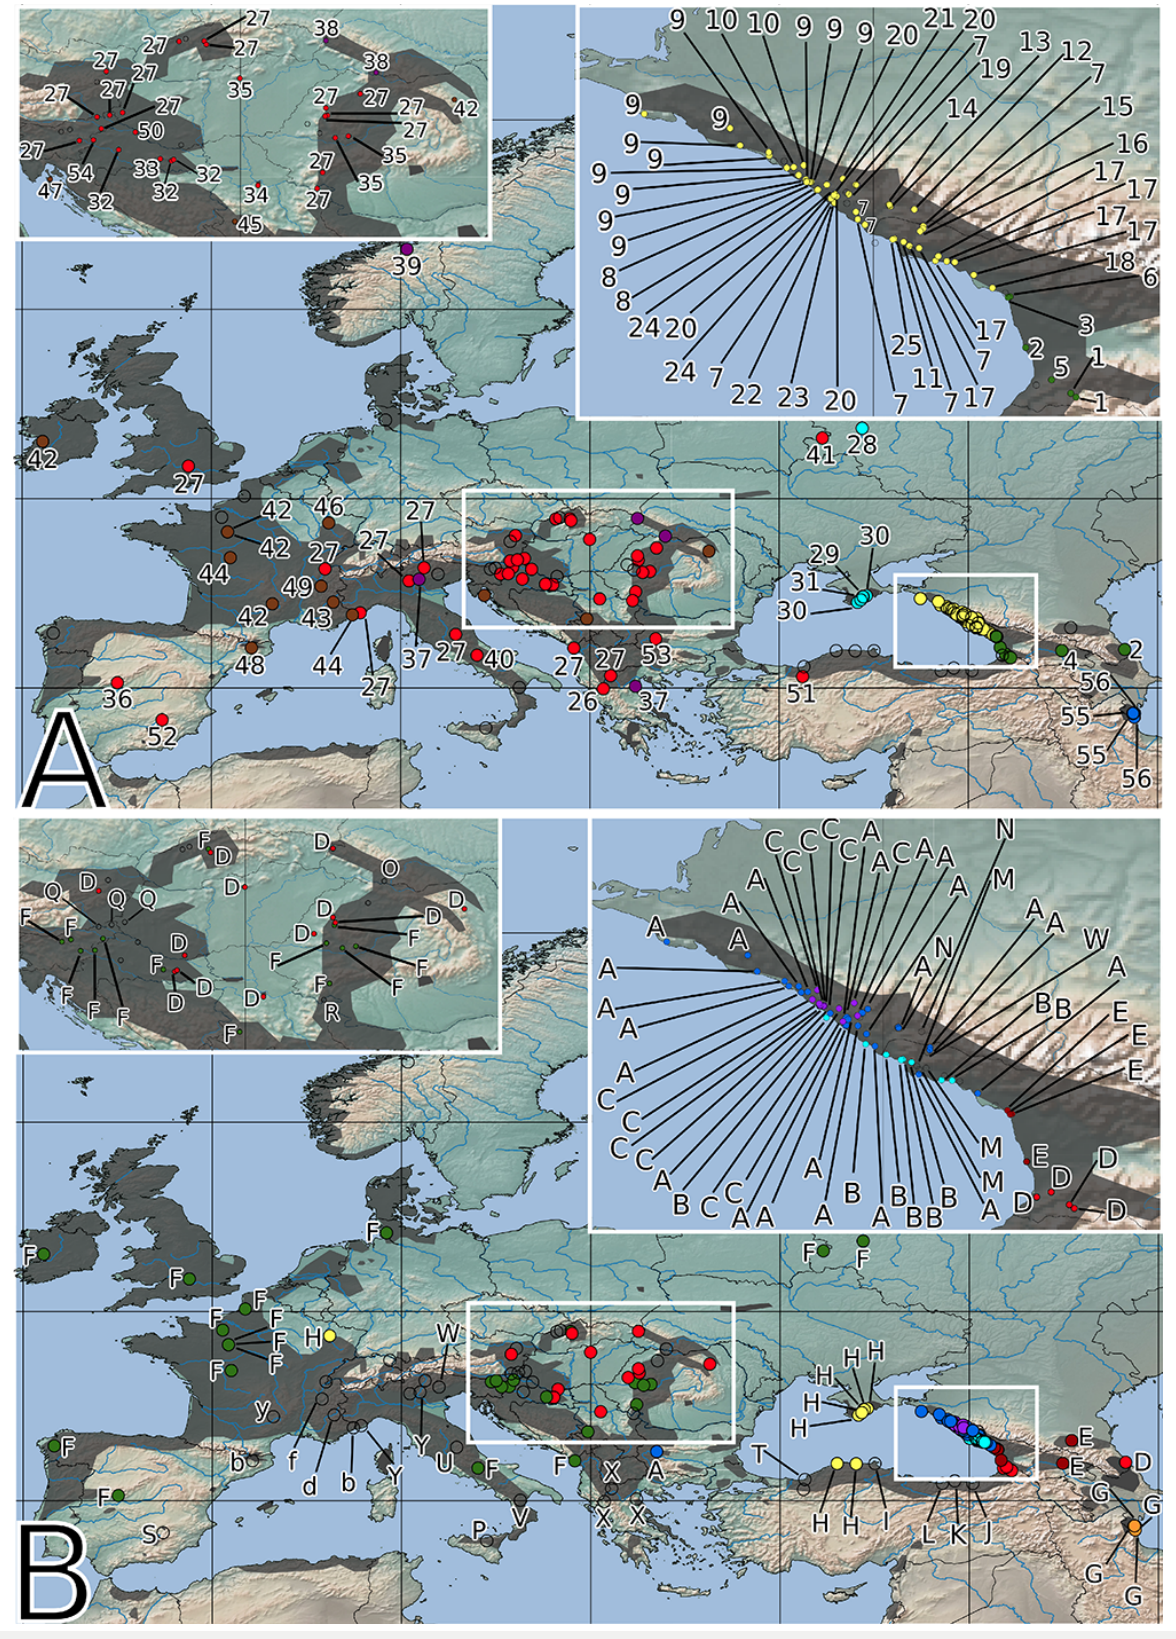
Figure 3 Spatial distribution of the identified haplotypes ( A ) and ribotypes ( B ). The color of the circles corresponds to that of the haplotypes and ribotypes shown in Figure 2. Empty circles represent samples that are missing from the plastid ( A ) or nrITS ( B ) dataset. The distribution range of Primula vulgaris is indicated by gray shading on the map.